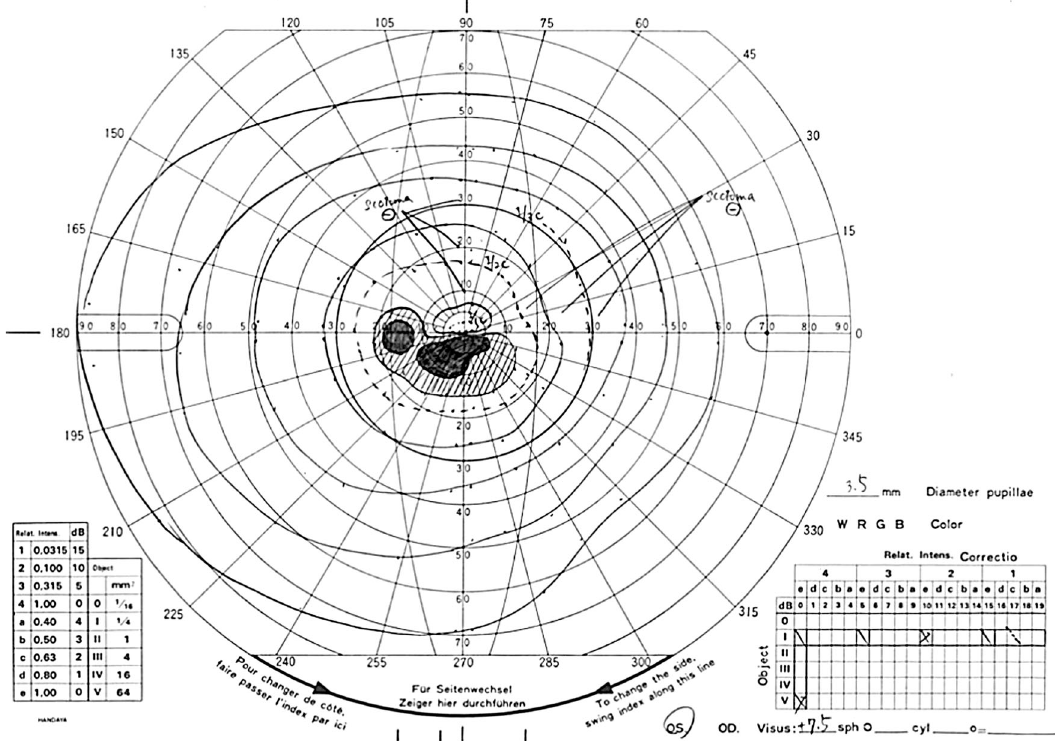
Figure 5: Visual fi eld test by Goldmann perimetry at 56 days from disease onset. A scotoma is seen from slightly below center to the ear side. The location of this paracentral scotoma coincides with the location of cilioretinal artery